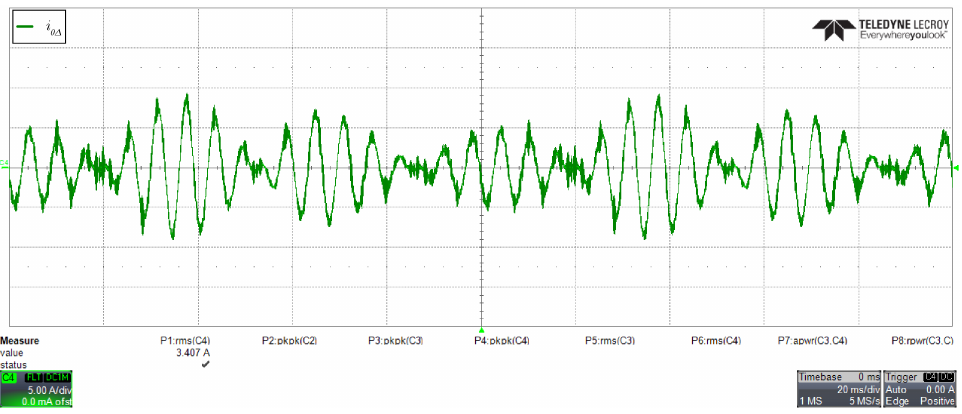
Figure 13. Circulating current in the Hexverter, with the unity power factor in both ports.